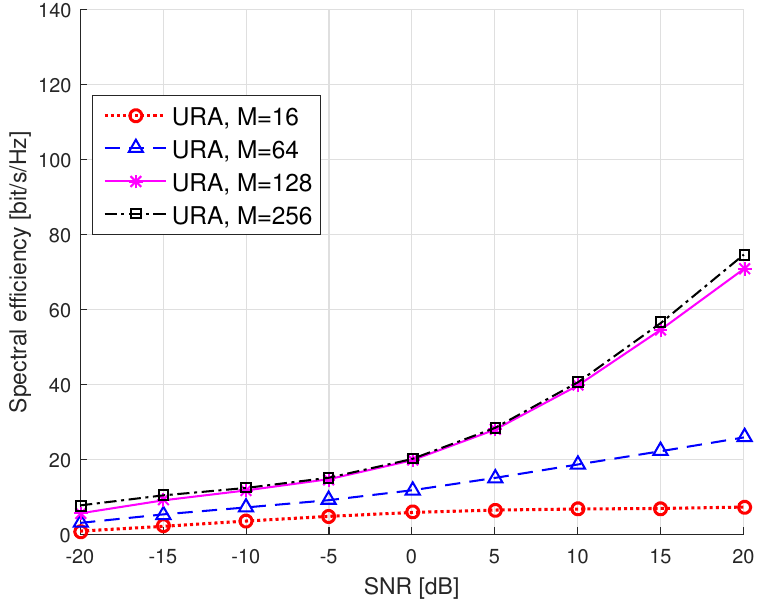
Figure 9. Spectral efficiency vs. SNR in dB for the URA topology, U = 10 UEs, azimuth standard deviation α A ( AS ) = 5, with different numbers of base station antennas.